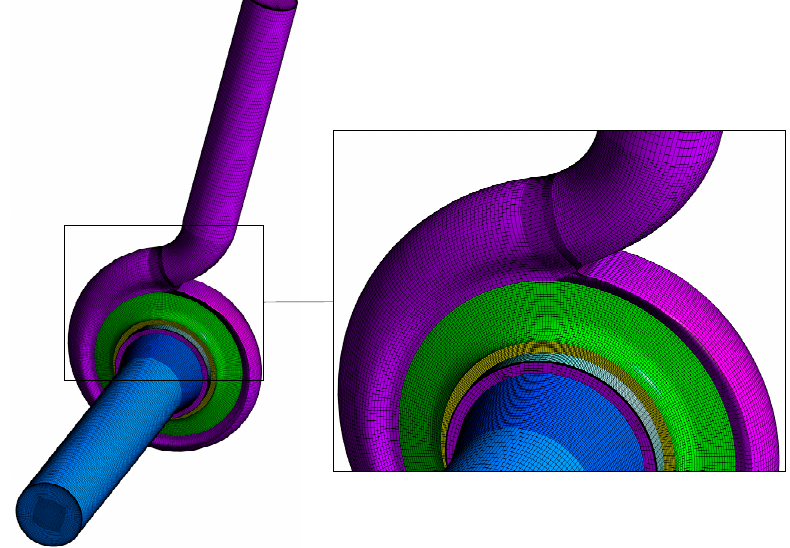
Figure 4. Three ‐ dimensional (3D) model of the centrifugal pump. Figure 4. Three-dimensional (3D) model of the centrifugal pump. Energies 2020 , 13 , 589